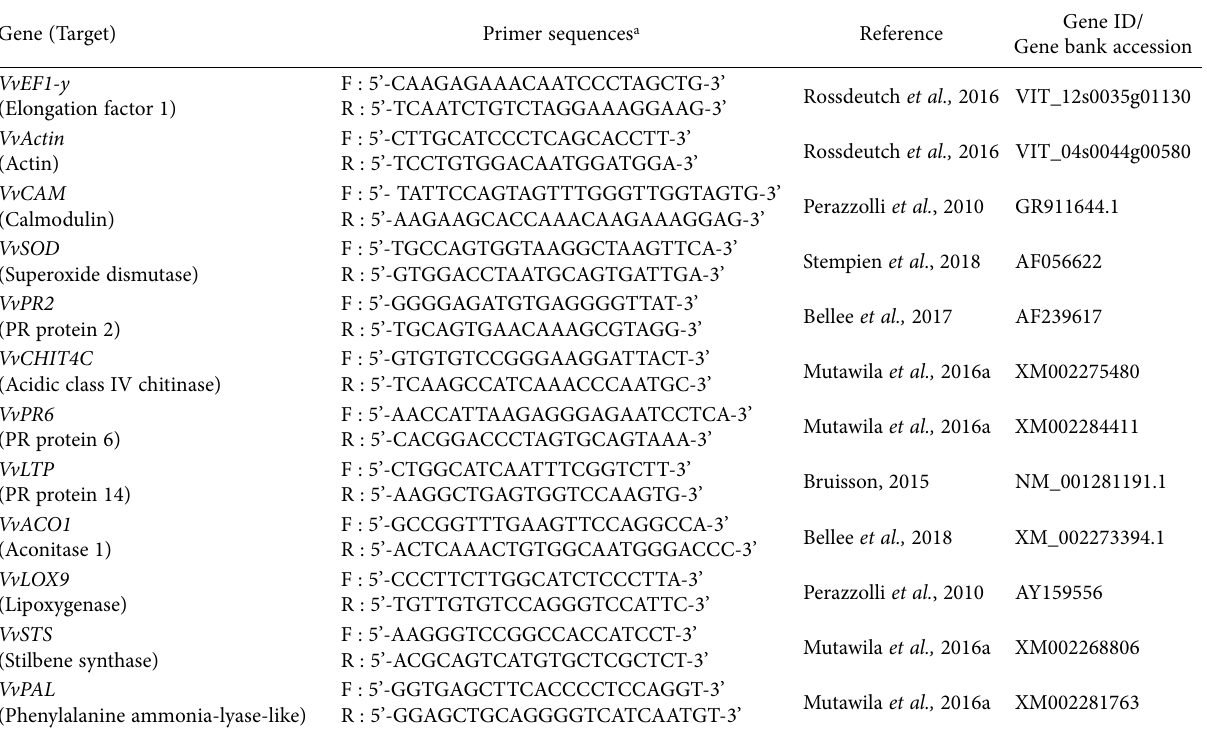
Table 1. Sequences of the primer pairs derivative of Vitis vinifera and used for RT-qPCR. Gene